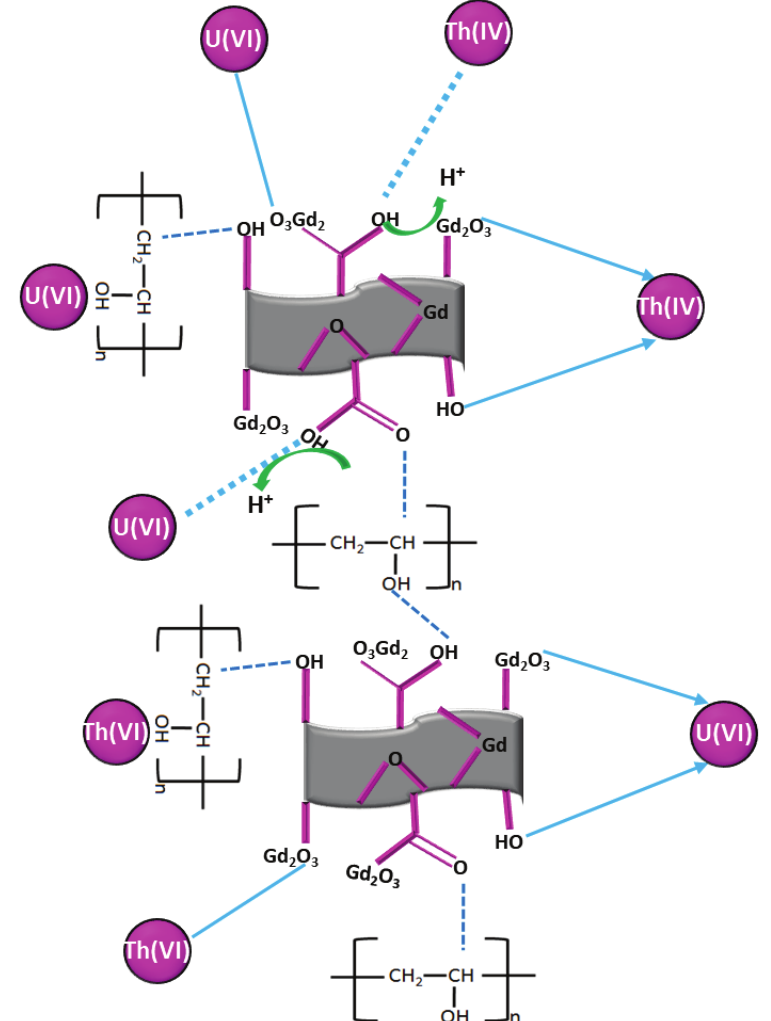
Figure 6. Possibility of U(VI) and Th(IV) adsorption mechanism on PGO–Gd.